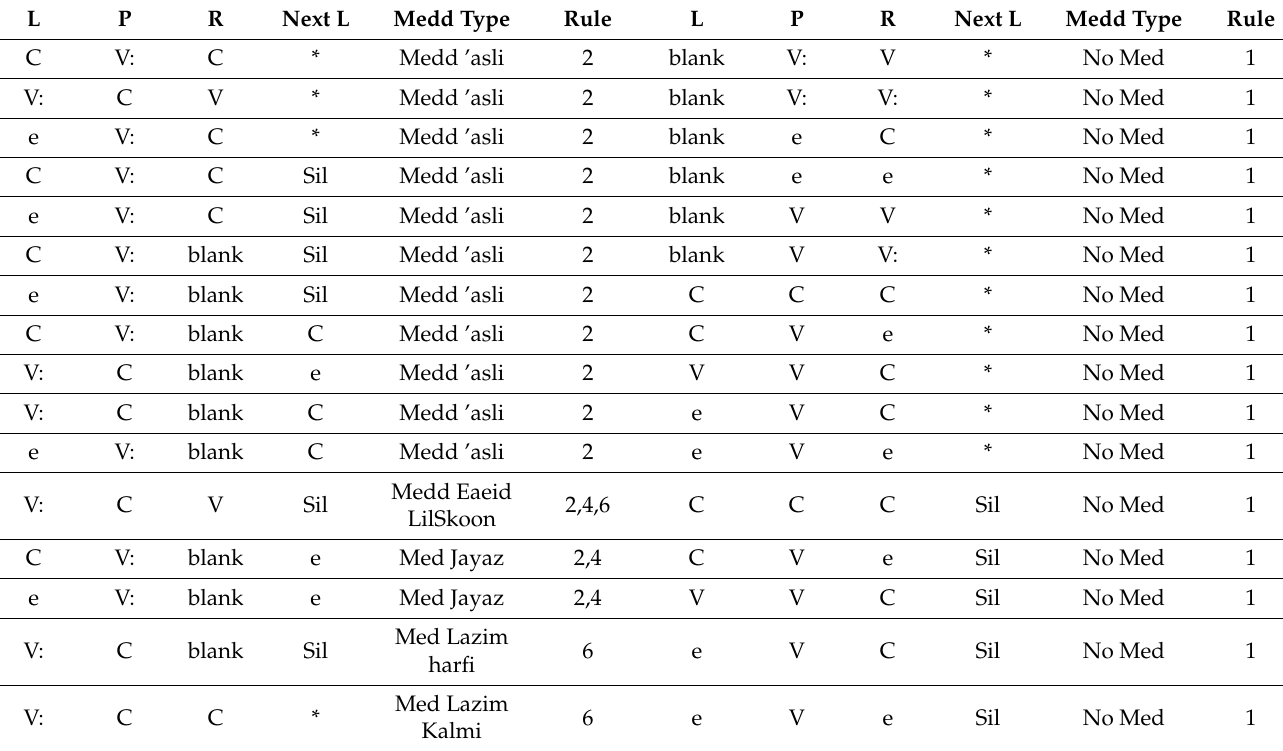
Table 3. Possible CV-triphone tree cases table based on Medd